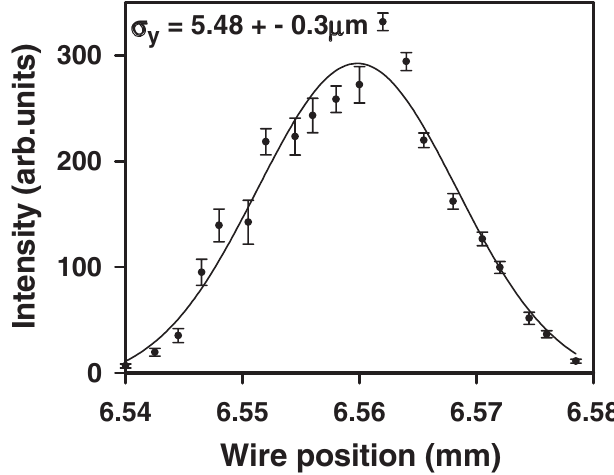
FIG. 14. Typical vertical beam profile measured with 10 (cid:8) m tungsten wire installed in the ODR